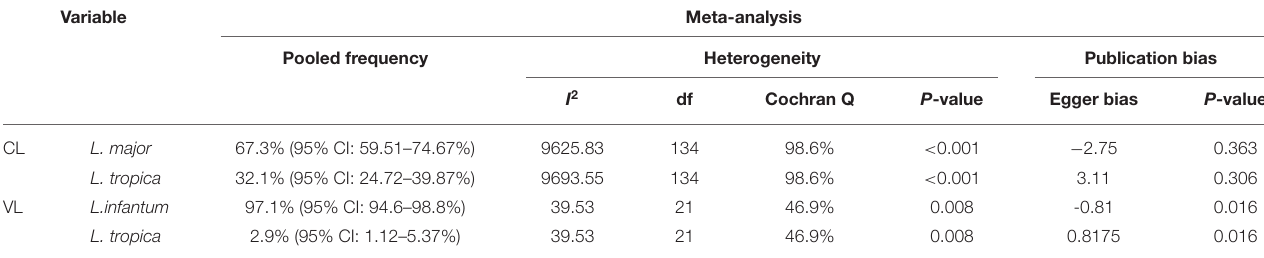
TABLE 3 | The pooled frequency, heterogeneity, and publication bias of Leishmania species that causative VL and CL leishmaniasis. Variable Meta-analysis Pooled frequency